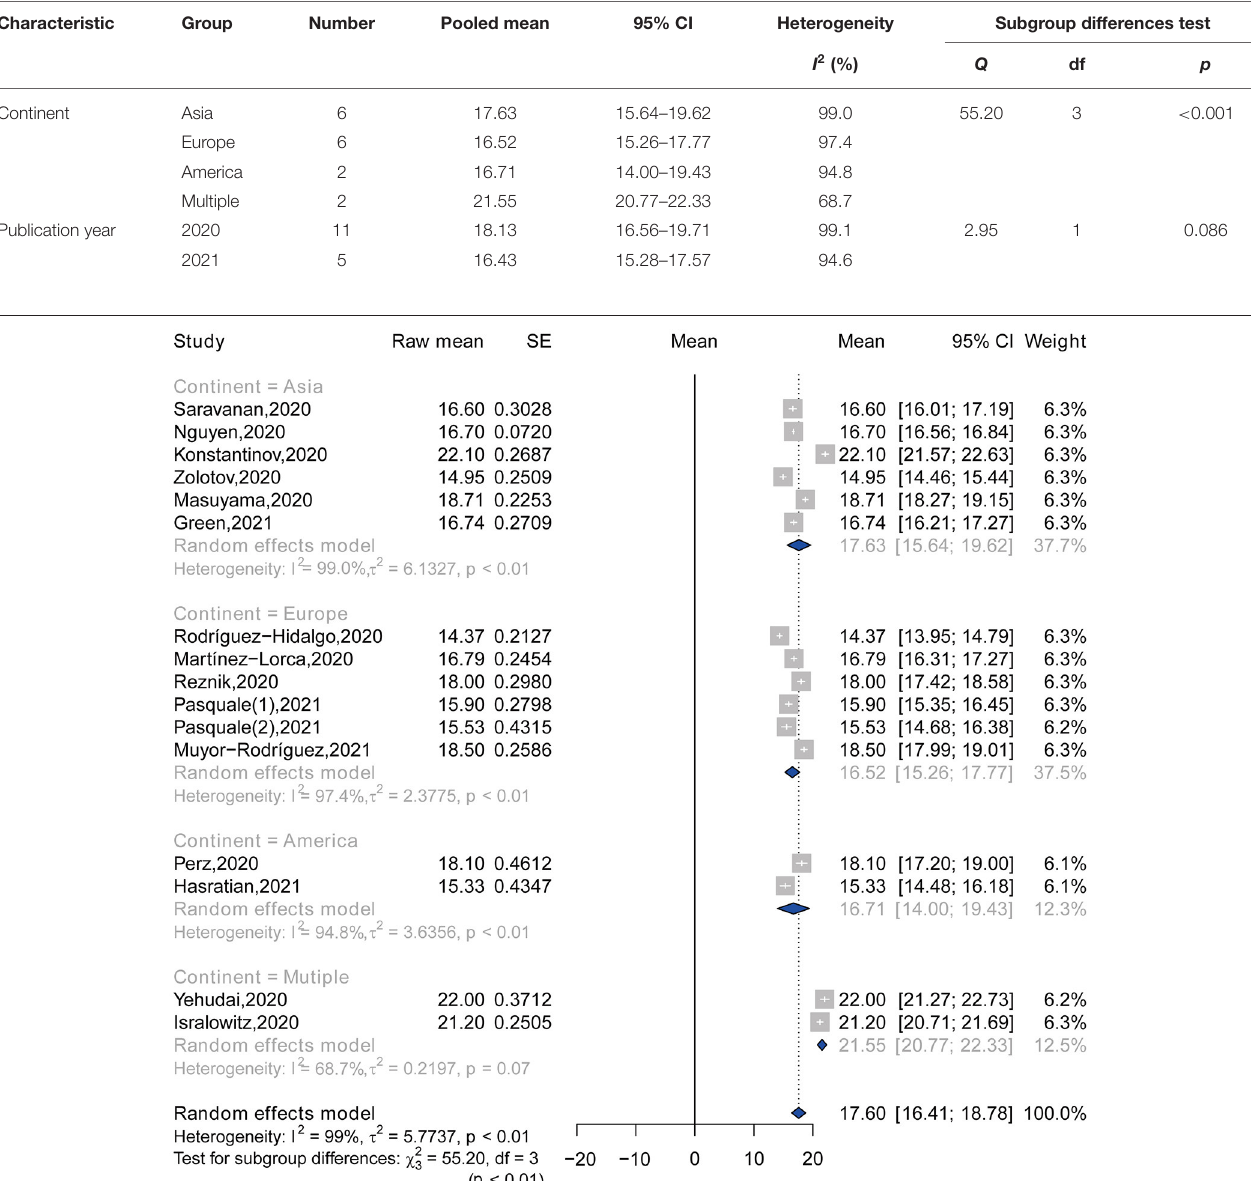
TABLE 3 | Subgroup analysis of the pooled mean of fear of COVID-19 by continent and publication year. Characteristic Group